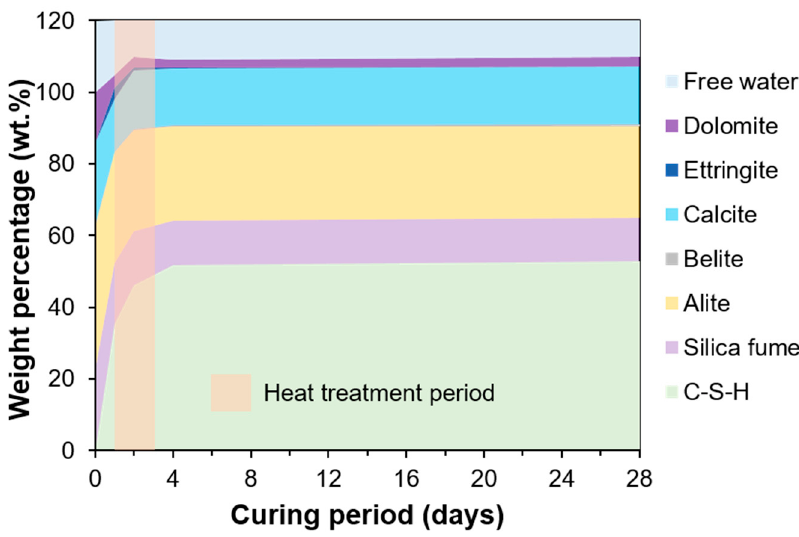
Figure 8. QXRD results after normalization to anhydrous content.